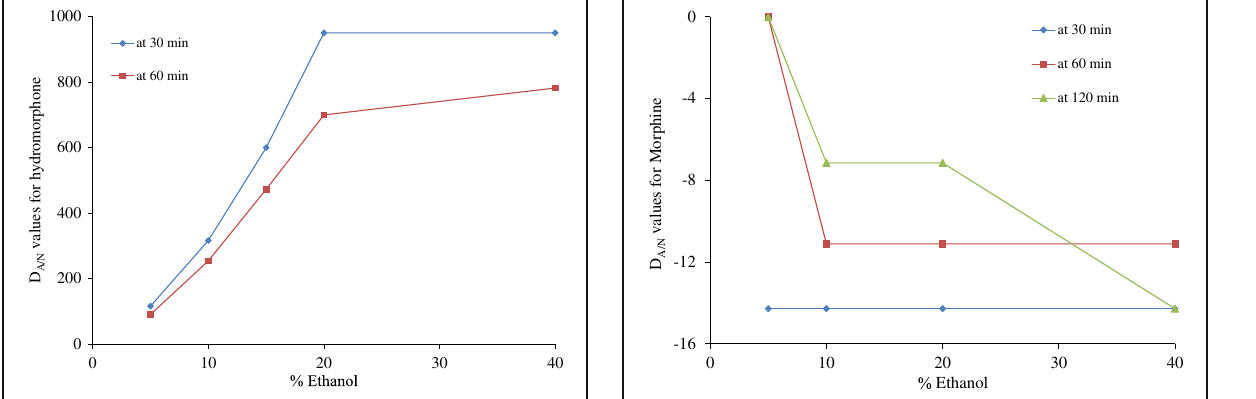
Fig. 5 D A/N values of hydromorphone from once daily capsules in SGF/ethanol (data from reference (Walden et al. 2007))